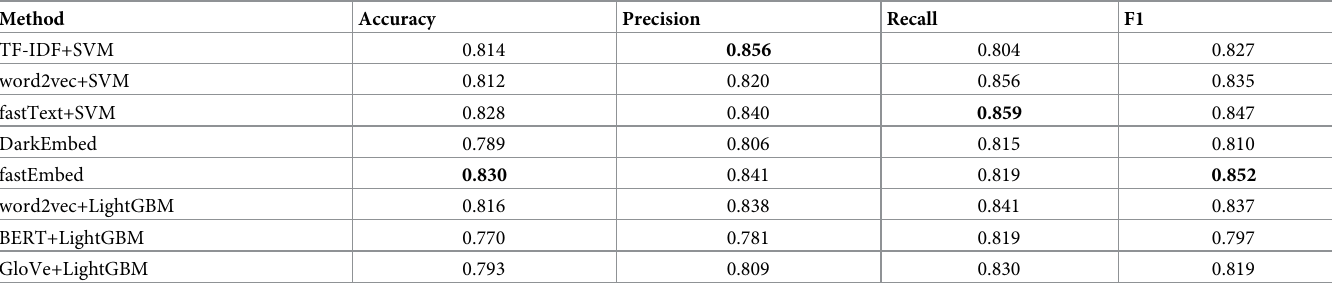
Table 11. Classification results on different